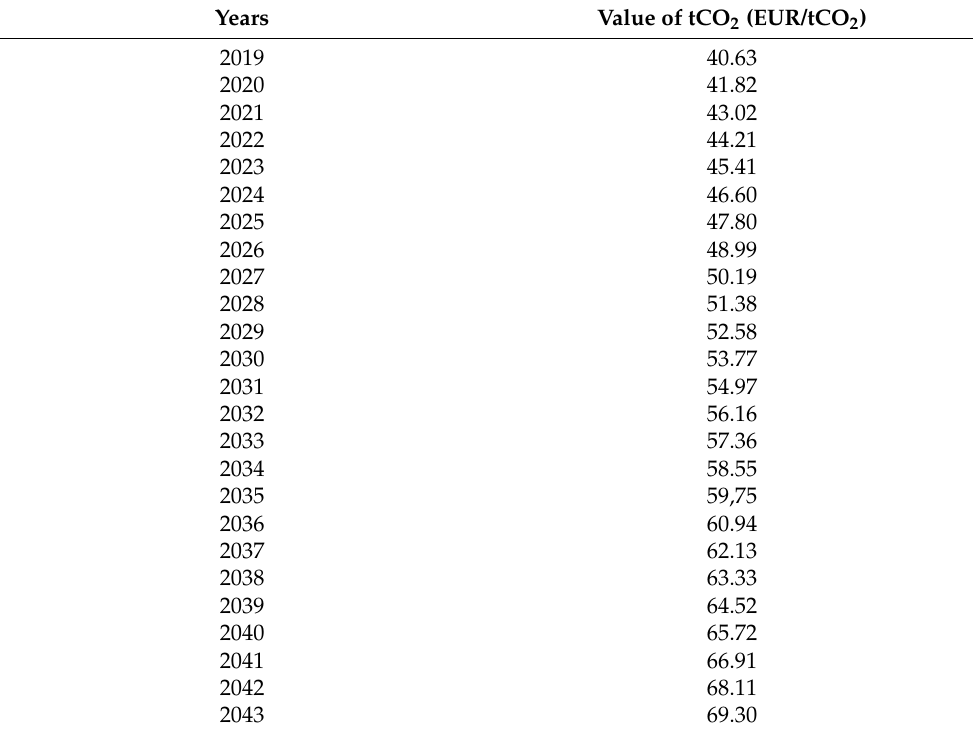
Table A7. Unit value of tCO 2 emission (EUR/tCO 2